Question: What type of chart is this?
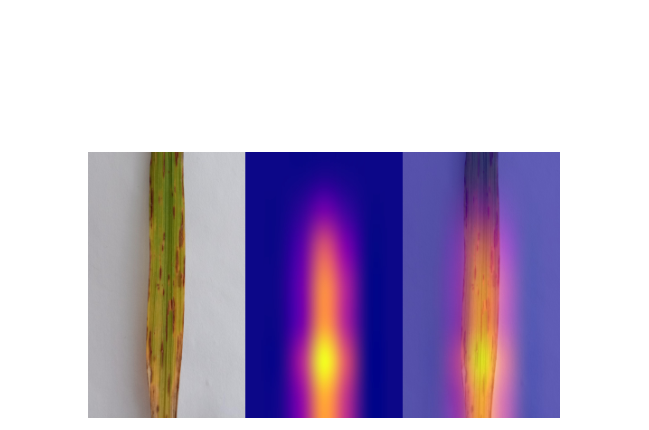
Answer: heatmap